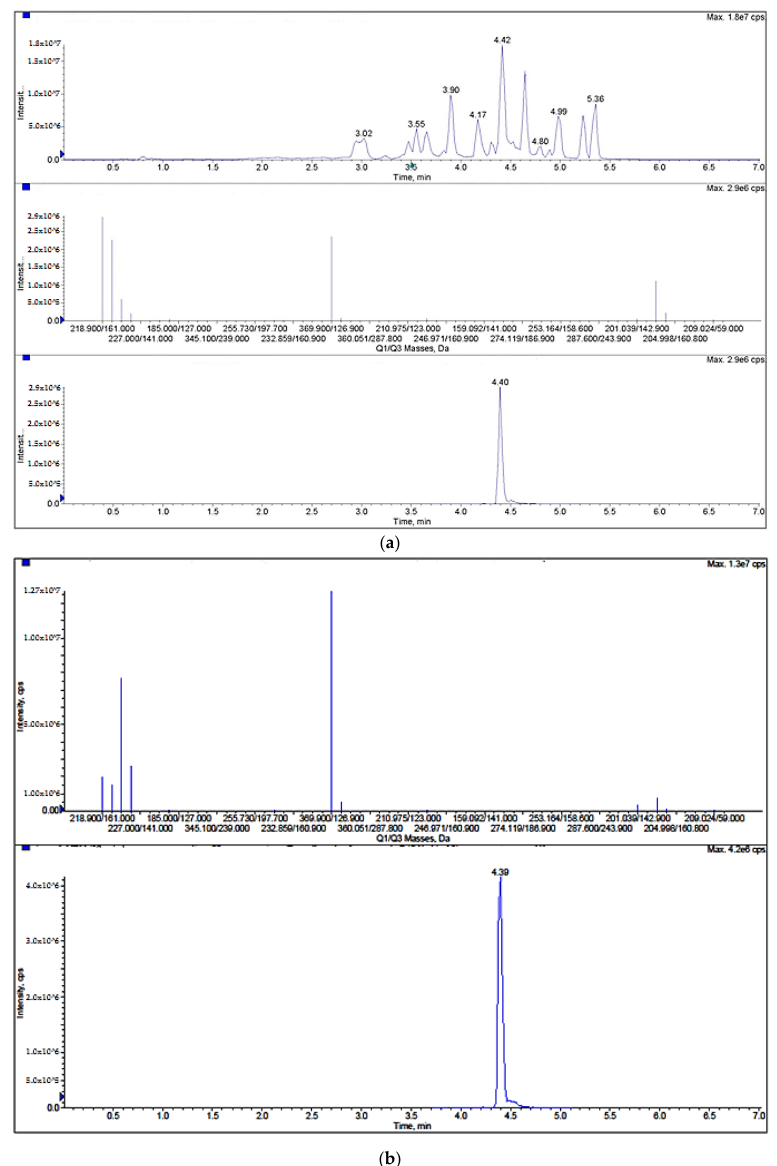
Figure 4. ( a ) Positive orange sample containing 2,4 D (total ion chromatogram, relation ions, and UHPLC–MS / MS chromatogram), and ( b ) relation ions and UHPLC–MS / MS chromatogram of a matrix-matched standard of